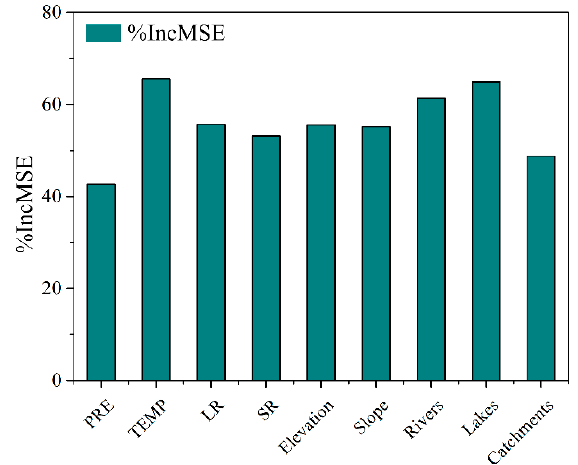
Figure 5. The importance of environment factors from the Random Forests model. The eight variables on the x-axis are precipitation (PRE), temperature (TEMP), downward long-wave radiation (LR), downward short-wave radiation (SR), elevation, slope, shortest distance to rivers, shortest distance to large lakes and river catchments. Mean Decrease Accuracy (%IncMSE) is the variable on the y-axis.